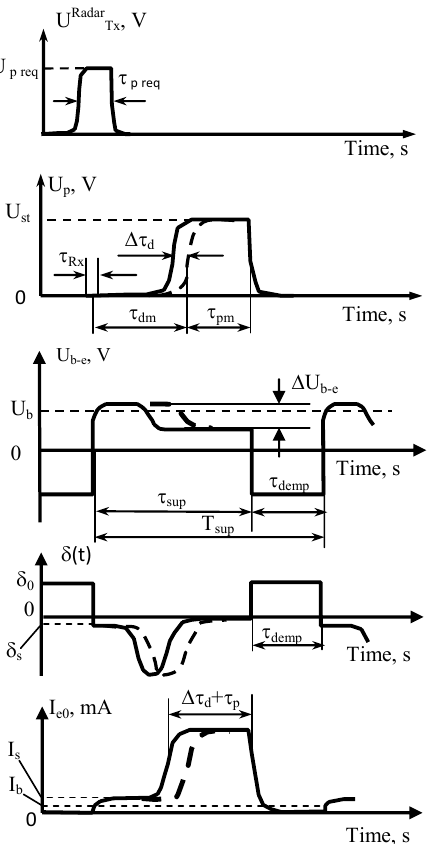
Fig. 2. Changing the duration of the emitted radio pulse of a super-regenerative transceiver when receiving a request signal from a